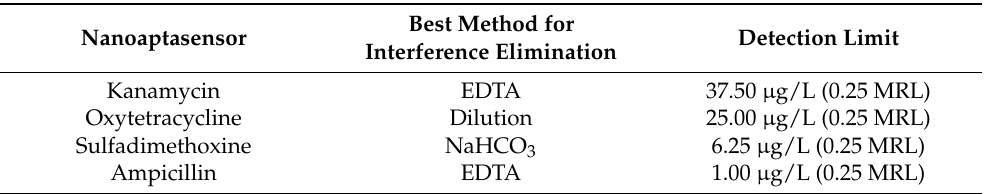
Table 4. Selected methods for the removal of cationic interferents, which provide the minimum detection limit of antibiotic for each NAS.